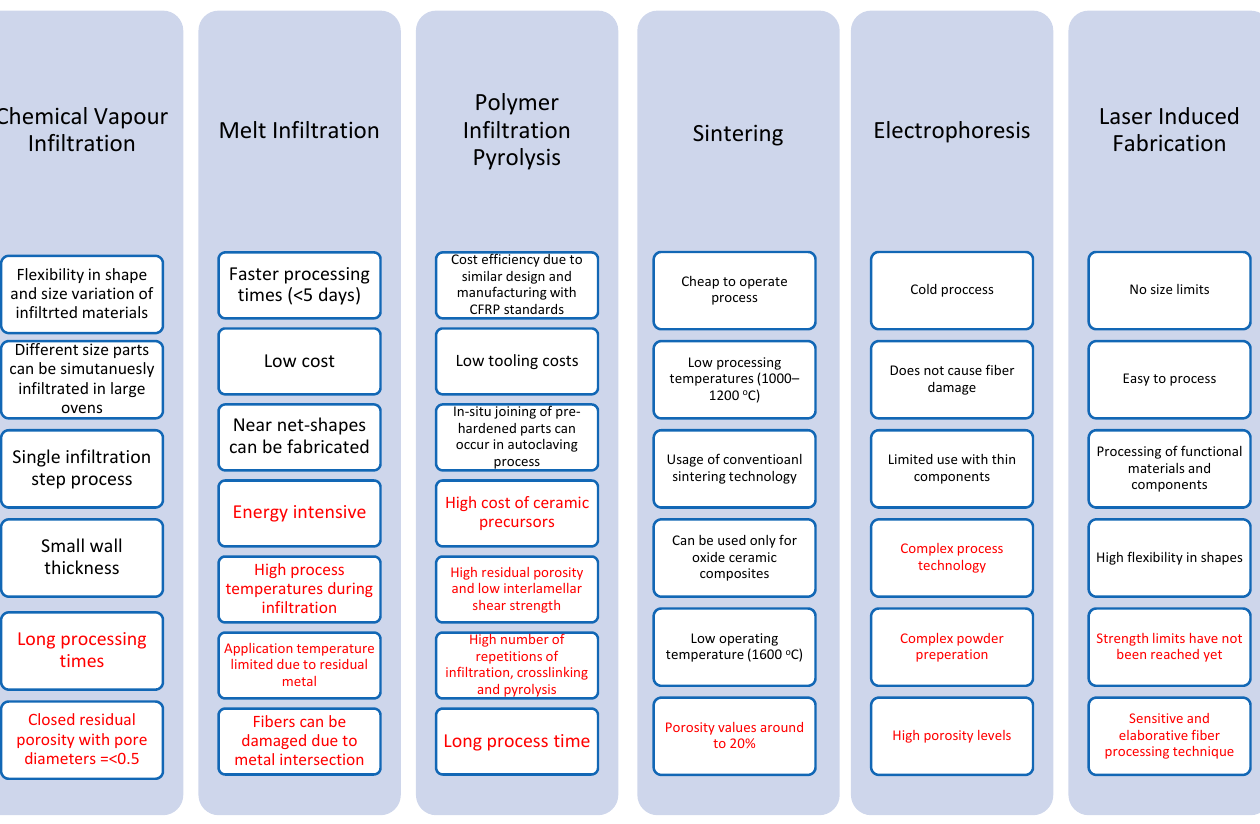
Figure 16. Fabrication procedure steps for CMCs.